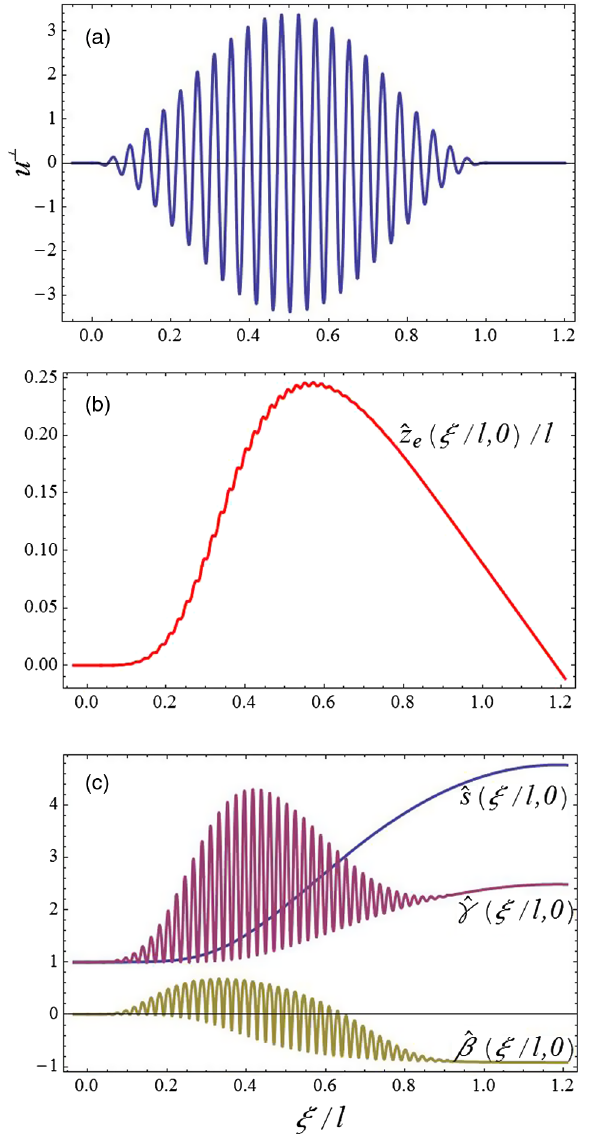
FIG. 7. (a) Laser pulse of average intensity I ¼ 10 19 W = cm 2 and shape as in Sec. IV, with l ¼ 18 . 75 μ m. (b – c) Corresponding solution of (14) – (15) for initial density e n 0 ð Z Þ ¼ n 0 θ ð Z Þ , with n 0 ¼ 21 × 10 17 cm − 3 (i.e. Ml 2 ¼ 26